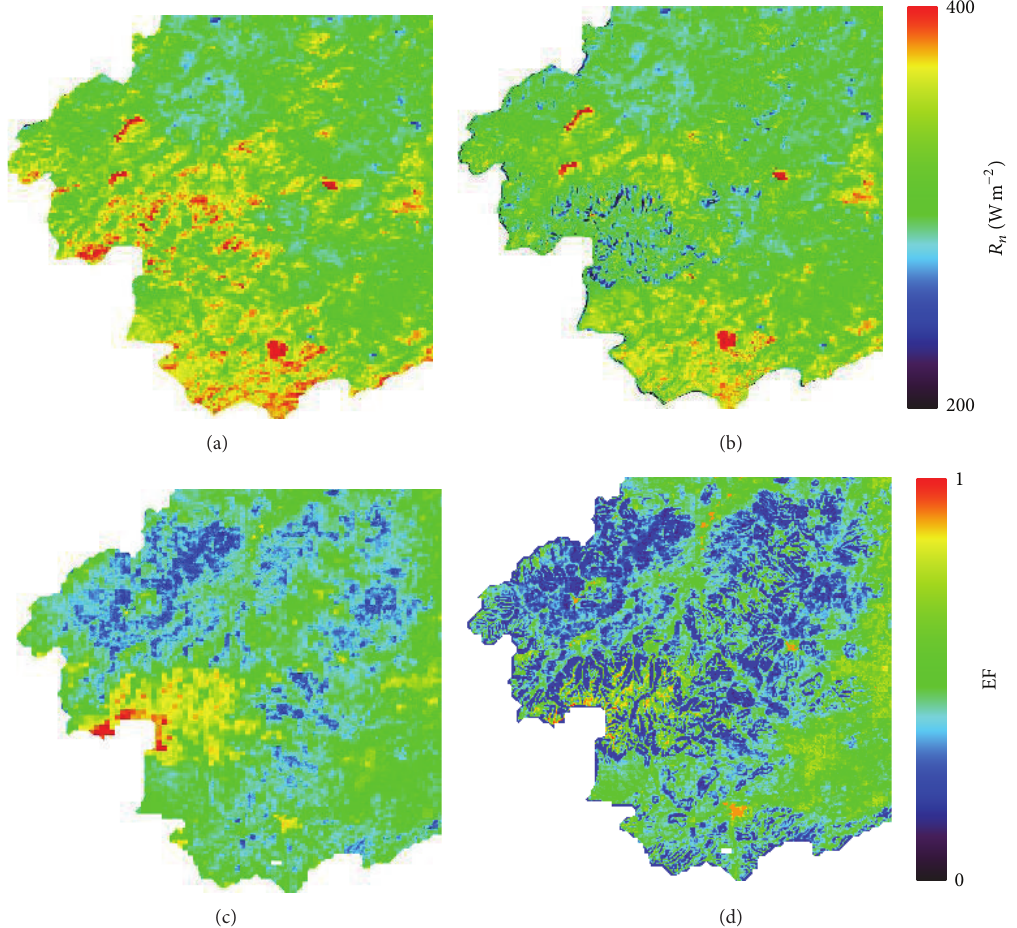
Figure 4: A map of net radiation (𝑅 𝑛 ) and evaporative fraction (EF) on September 26, 2006, over the selected Taihu Basin region; (a) the 𝑅 𝑛 before topographic correction, (b)